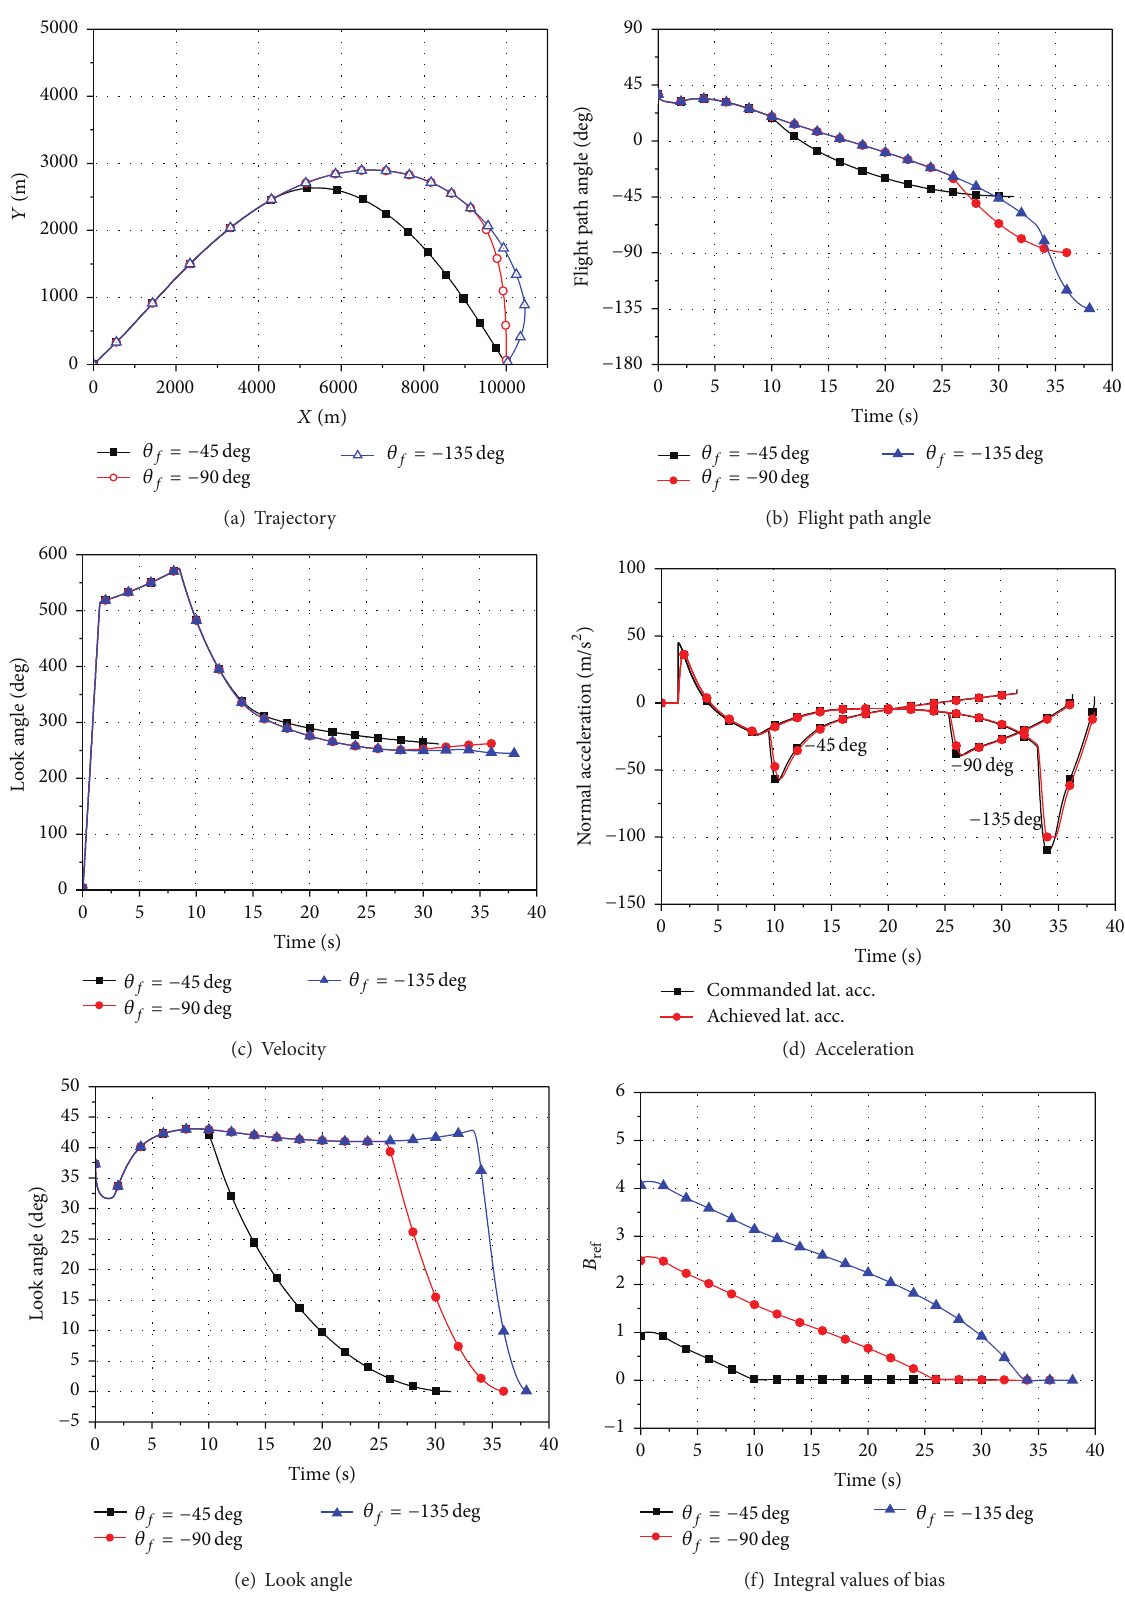
Figure 5: Simulation results for realistic missile